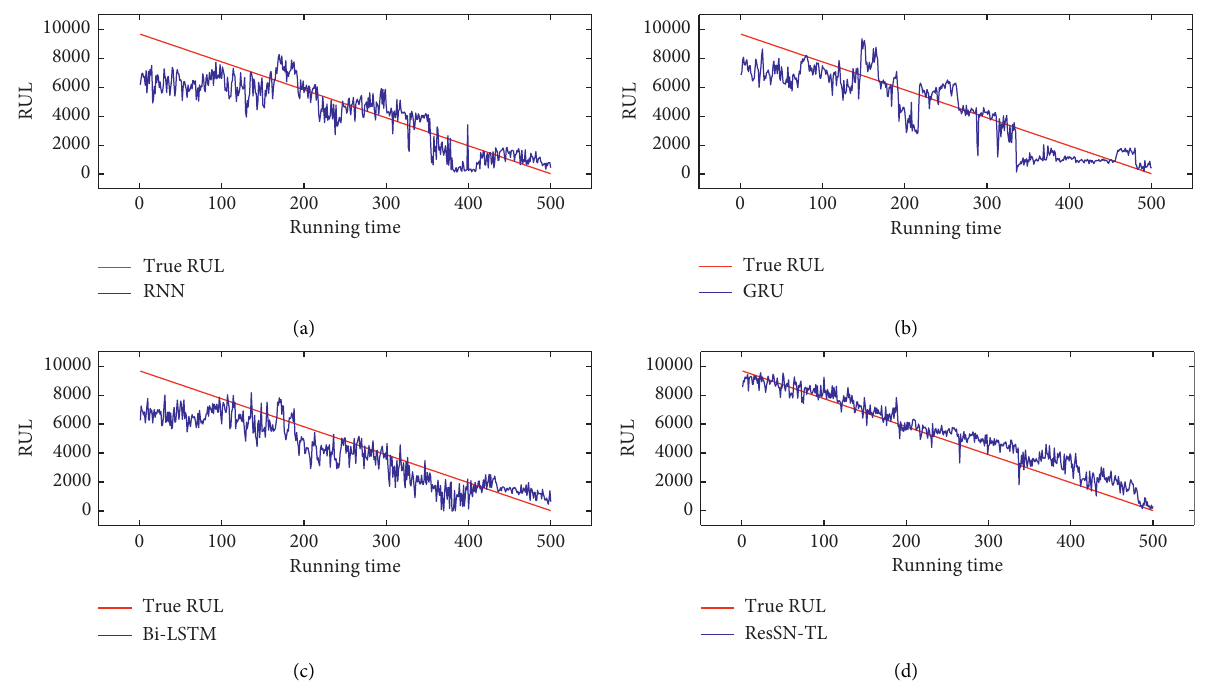
Figure 12: RUL prediction results of bearing dataset 2–2, (a) RNN, (b) GRU, (c) Bi-LSTM, and (d) ResSN-TL.